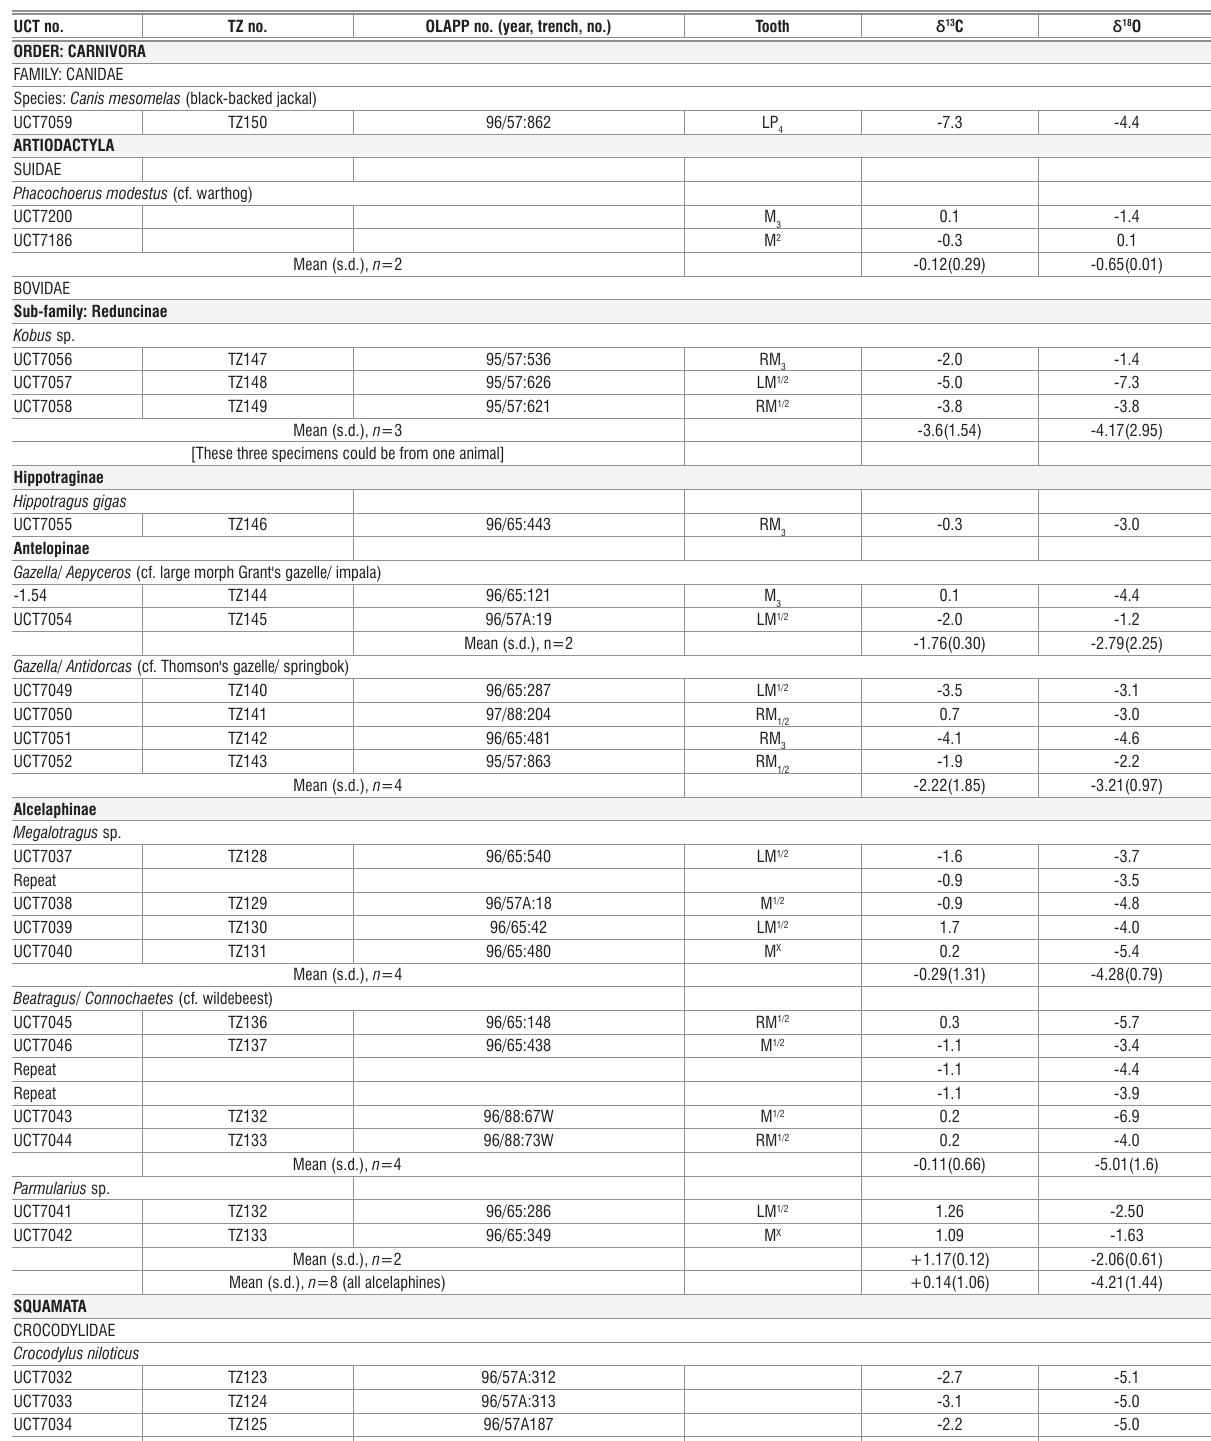
Table 1: Carbon and oxygen stable isotope ratios in tooth enamel of fossil fauna from Olduvai West Middle Bed I. [Stratigraphy: above Tuff 1B, 1.83 Ma; below 1.785 Ma].